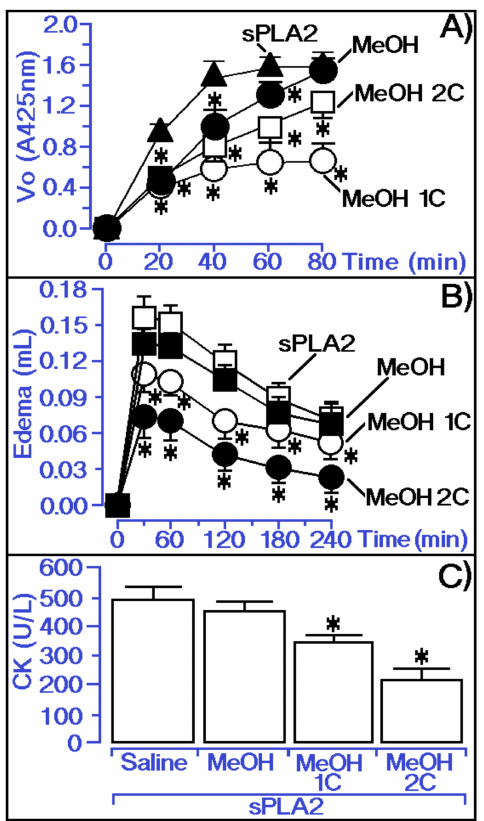
Figure 5. Comparative analysis of 1C and 2C fractions from methanol extract incubated with sPLA2 on enzymatic (Figure 5A), edematogenic (Figure 5B), and myotoxic activities (Figure 5C) of isolated sPLA2. ( A ) Activity of the MeOH, MeOH 1C and 2C on phospholipase A2 enzymatic activity, where saline represents the control group. The results are expressed as a variation of enzymatic velocity Vo, and the error bars indicate the SEM. * Statistically significant di ff erences ( n = 5, p < 0.05) compared to native sPLA2. ( B ) show paw edema induced after the injection of sPLA2 and sPLA2 treated with MeOH extract and MeOH 1C and MeOH 2C, respectively, into the right paws of Swiss mice. Edema is expressed as volume in µ L and measurements were performed after 30, 60, 120, 180, and 240 min. The error bars indicate the SEM of five experiments. * p < 0.05 compared to native sPLA2. ( C ) show the myonecrosis assay and the results are expressed as creatine kinase (CK) units of enzymatic activity per liter (U / L). The error bars indicate the SEM of five experiments. * p < 0.05 compared with native